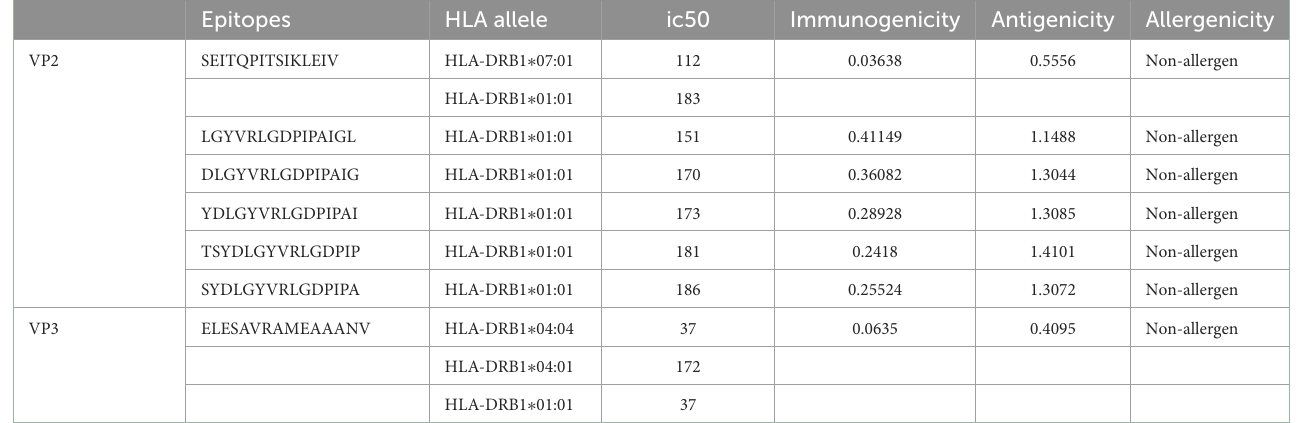
TABLE 2 Final predicted Helper T cells (CD4 + /HTL)